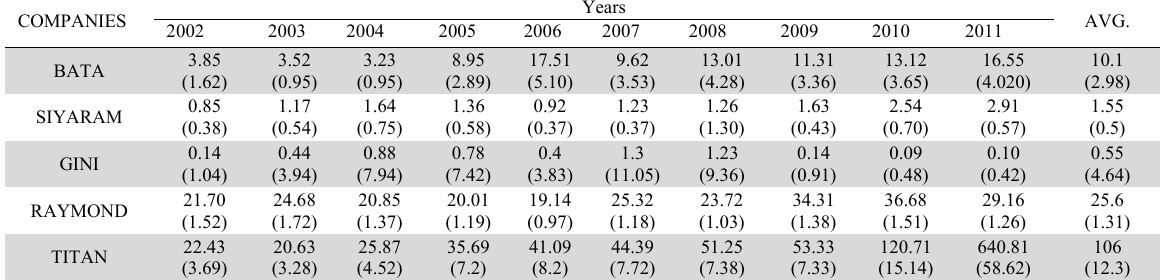
Rs. in crore (also in % of total